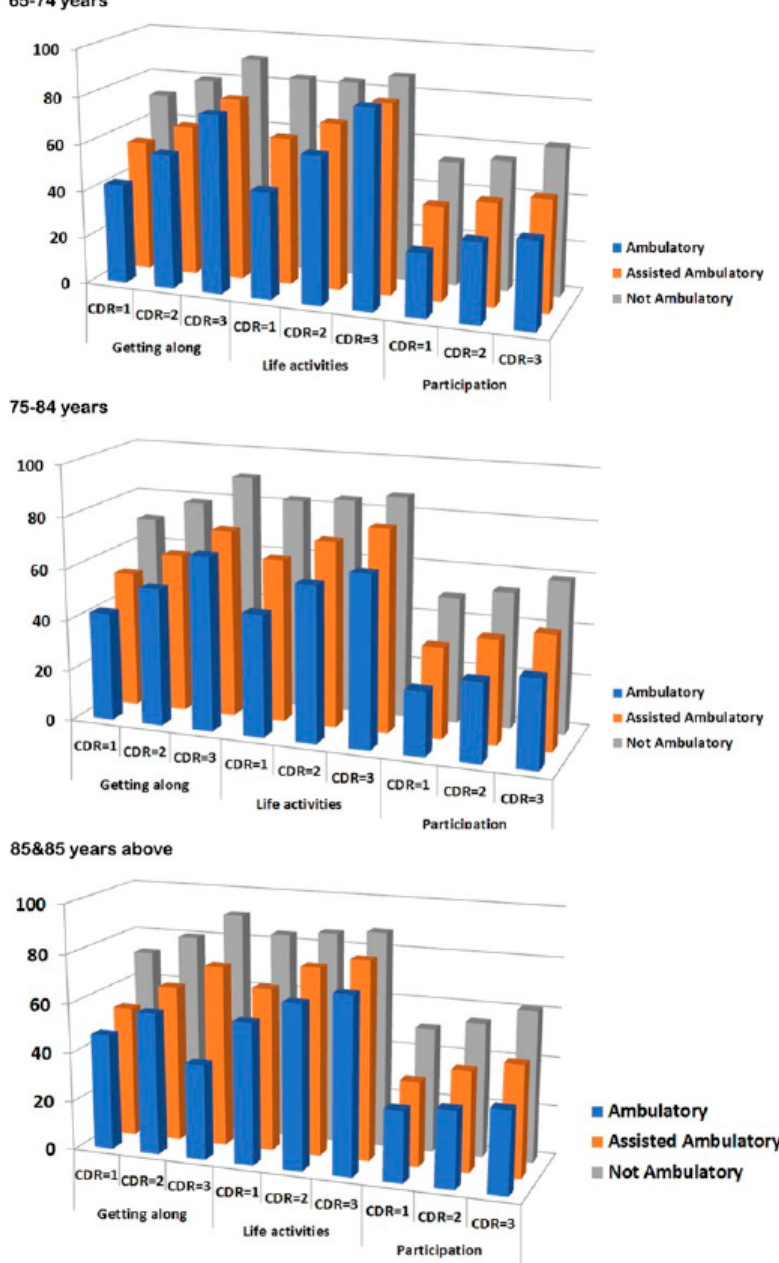
Figure 2. Di ff erent domains of World Health Organization Disability Assessment Schedule Figure 2. Different domains of World Health Organization Disability Assessment Schedule 2.0